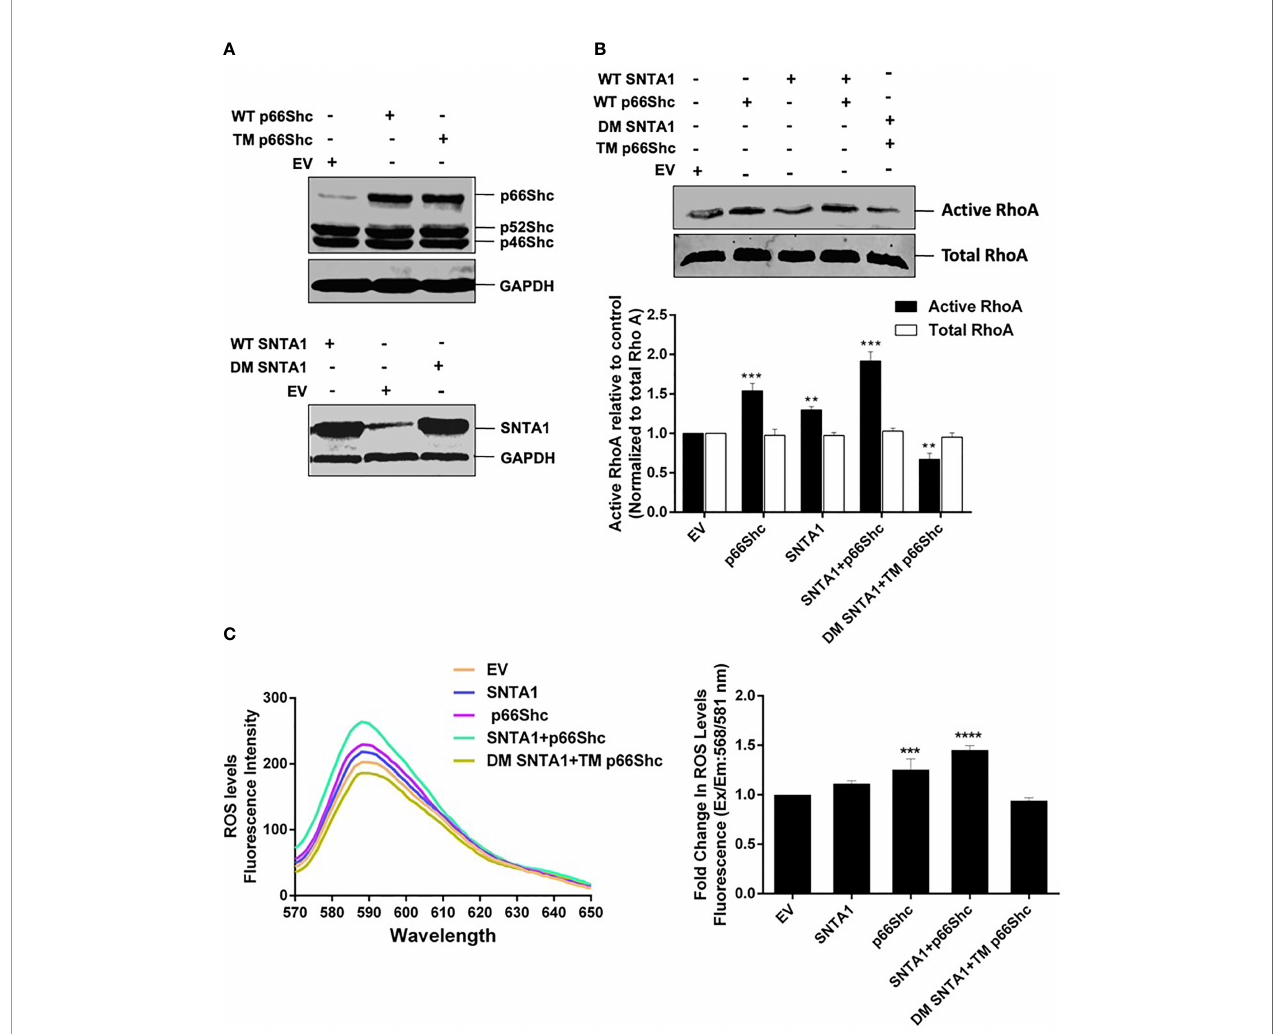
FIGURE 3 | SNTA1-p66Shc interaction is required for ROS induced RhoA activation. (A) Representative western blots showing exogenous expression of wild type and mutant forms of p66Shc and SNTA1 protein in MDA-MB-231 cells. GAPDH was used as control. (B) Representative western blot showing the relative levels of active RhoA in cells transfected with either vector control (EV) or indicated plasmid constructs. The RhoA activation levels were normalized against total RhoA from whole cell lysates and the relative change in active RhoA levels was determined in comparison to control. The densitometric bar graphs of western blots show the relative change in RhoA protein activation levels in response to over expression of wild type and mutant forms of SNTA1 and p66Shc proteins. Results shown were repeated three times and are expressed as mean ± SD fold change over control level set to 1 unit. The statistical analysis was done using two-way ANOVA followed by Sidak`s multiple comparison test to determine level of signi fi cance. **P <0.01;***P < 0.001. (C) The emission spectra of amplex red reagent showing the amount of H 2 O 2 generated in MDA-MB-231 cells over expressing wild type and mutant forms of SNTA1 and p66Shc proteins. The emission spectra were recorded in the wavelength range of 570-650 nm recorded, under an excitation wavelength of 568 nm. The bar graph illustrates the fold change in l max ( fl uorescence intensity at 588 nm) in MDA-MB-231 cells over expressing either WT SNTA1, WT p66Shc, WT SNTA1+WT p66Shc (co- expressed), DM SNTA1+TM p66Shc (co-expressed) in comparison to EV control. Results shown were repeated three times and are expressed as mean ± SD fold change over control level set to 1 unit. The statistical analysis was done using one-way ANOVA followed by Dunnett`s multiple comparison test to determine level of signi fi cance. ***P < 0.001; ****P